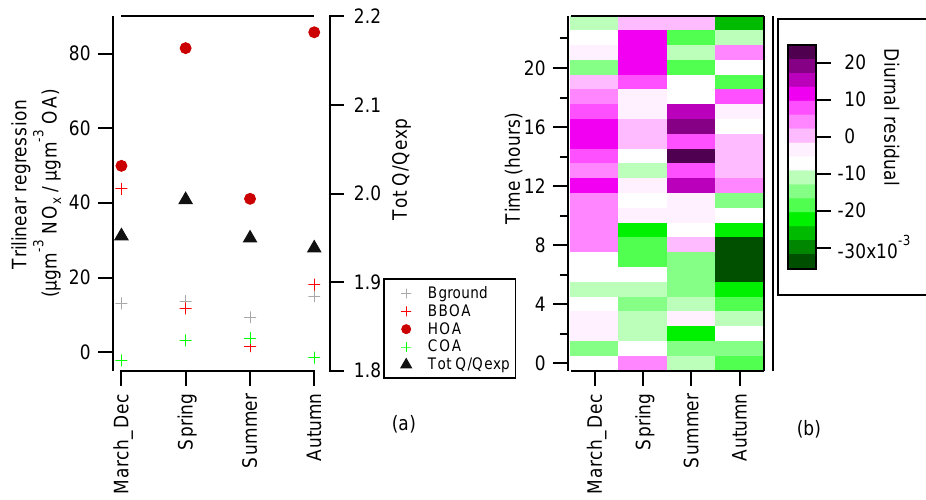
Figure 3. NO x trilinear regression (a) and diurnal residual (b) for the different analyses.